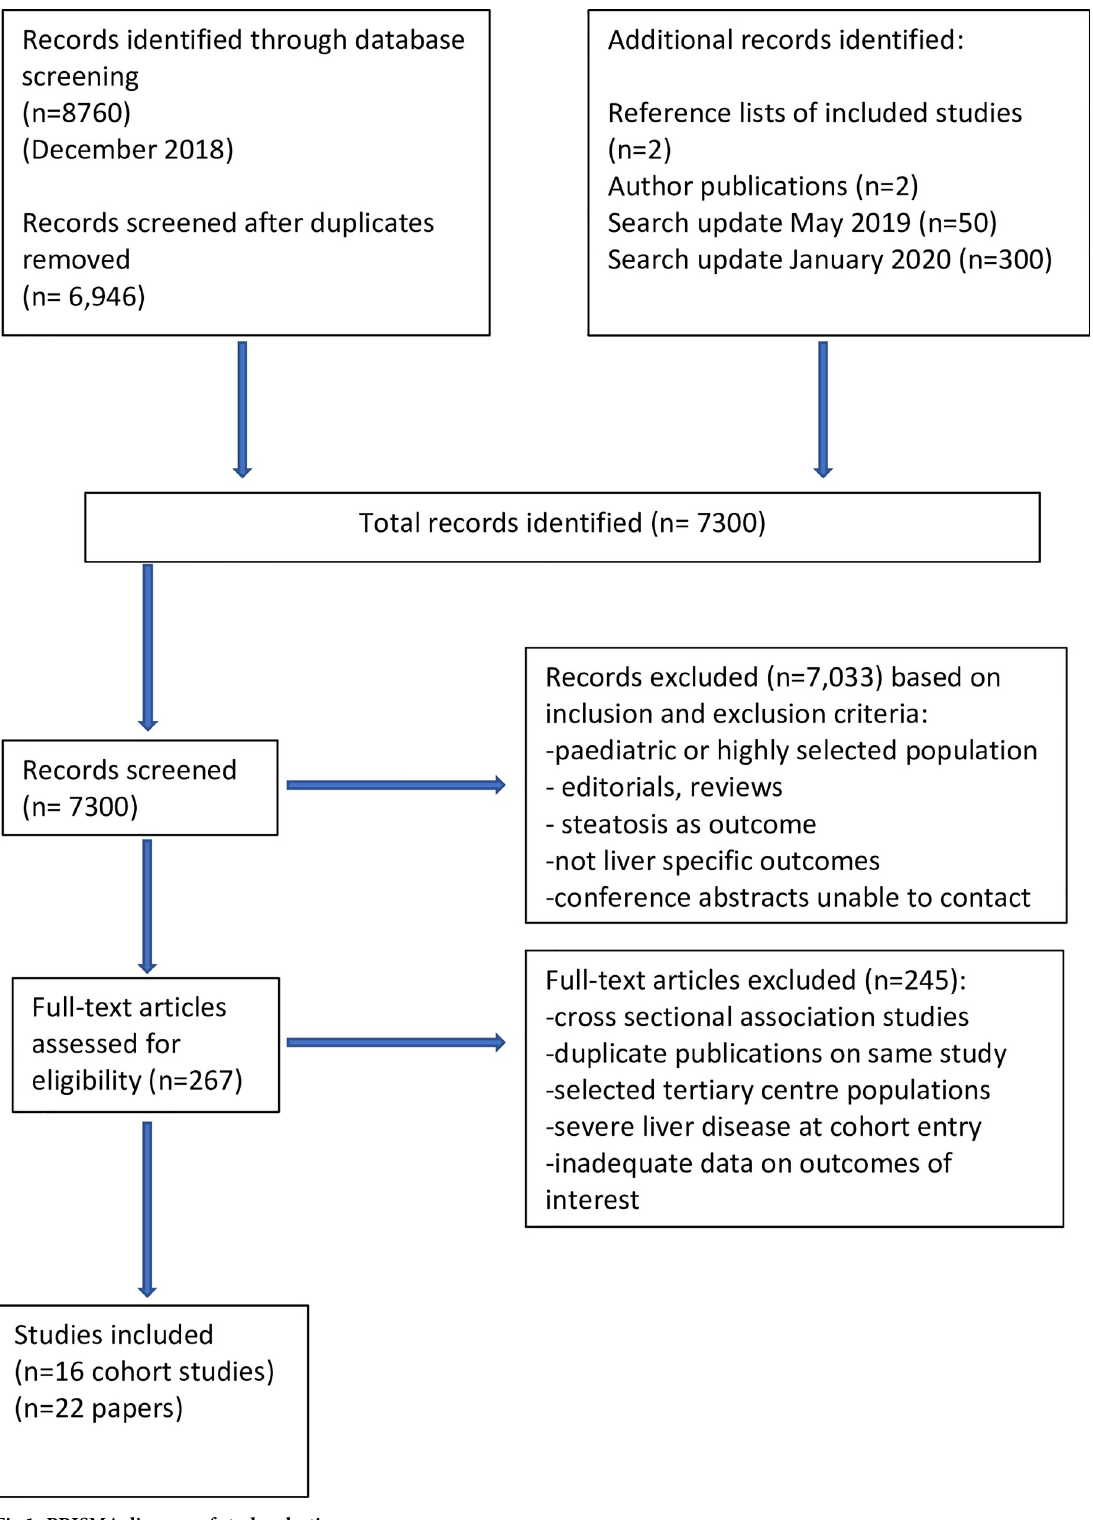
Fig 1. PRISMA diagram of study